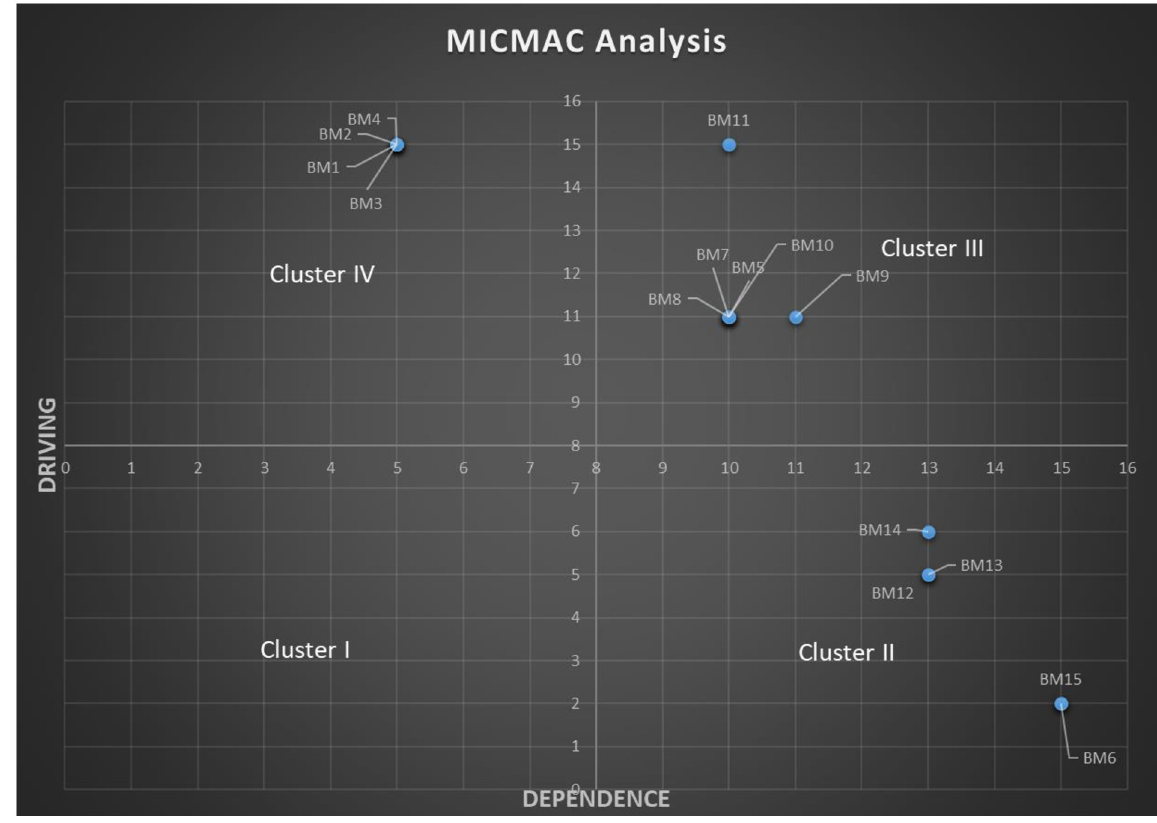
Fig 4. Driver power–dependence